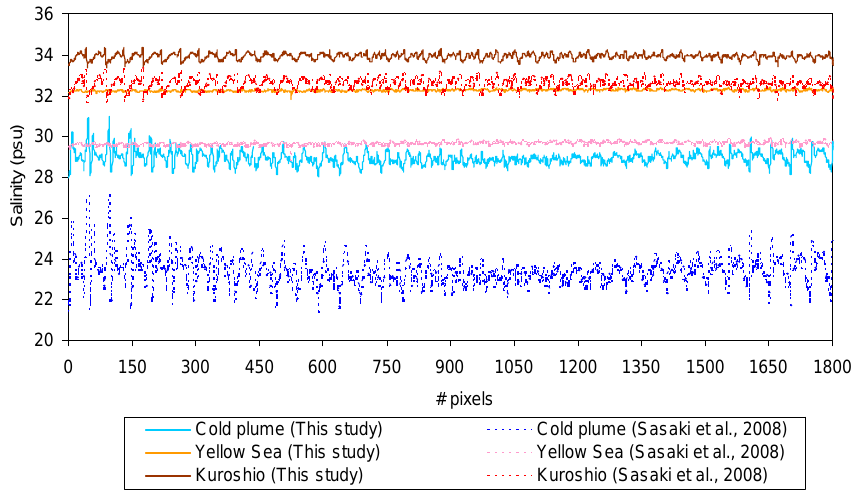
Fig. 11. Comparison of salinity estimations from the nonlinear model (this study) and linear model (proposed by Sasaki et al., 2008) applied to SeaWiFS image of 10 May 2001 at three water types (YR estuary, YS and Kuroshio waters). Mean salinity from the NLSM is 28.9psu in the LSW plume, 32.2psu in the YS, and 33.9psu in the Kuroshio region, whereas mean salinity from the LSM is 23.3psu in the LSW plume, 29.4psu in the YS, and 32.5psu in the Kuroshio region. The linear model is expressed as: Salinity (psu)= − 19 . 5 × a CDOM (400) (m − 1 )+34.5 (with R 2 =0.66 and N =43).